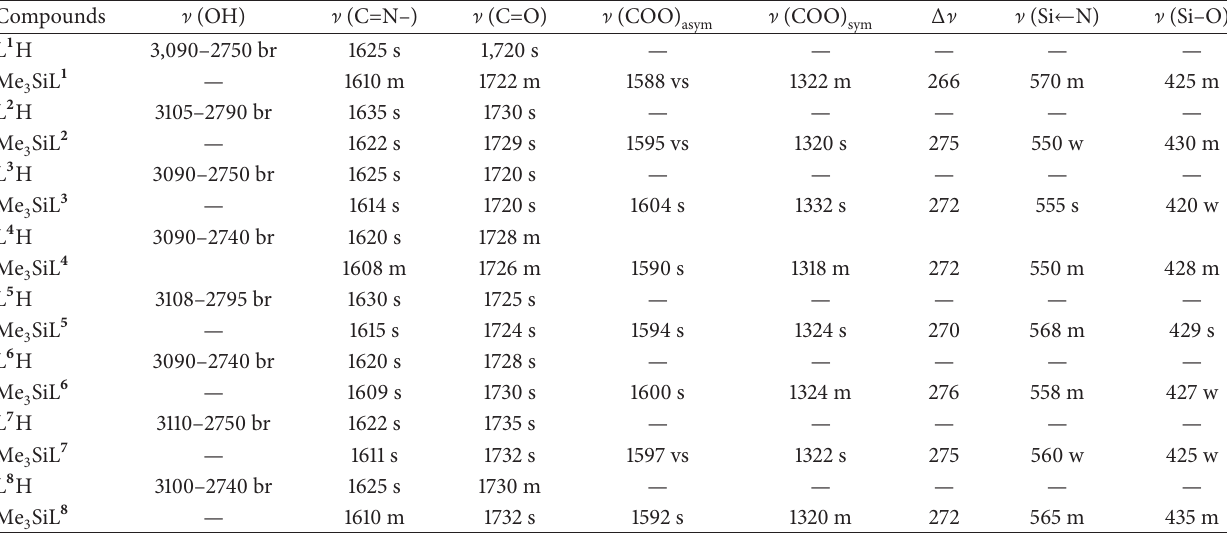
Table 2: Important IR spectral data (cm − 1 ) of Schiff bases and their corresponding organosilicon(IV) complexes.